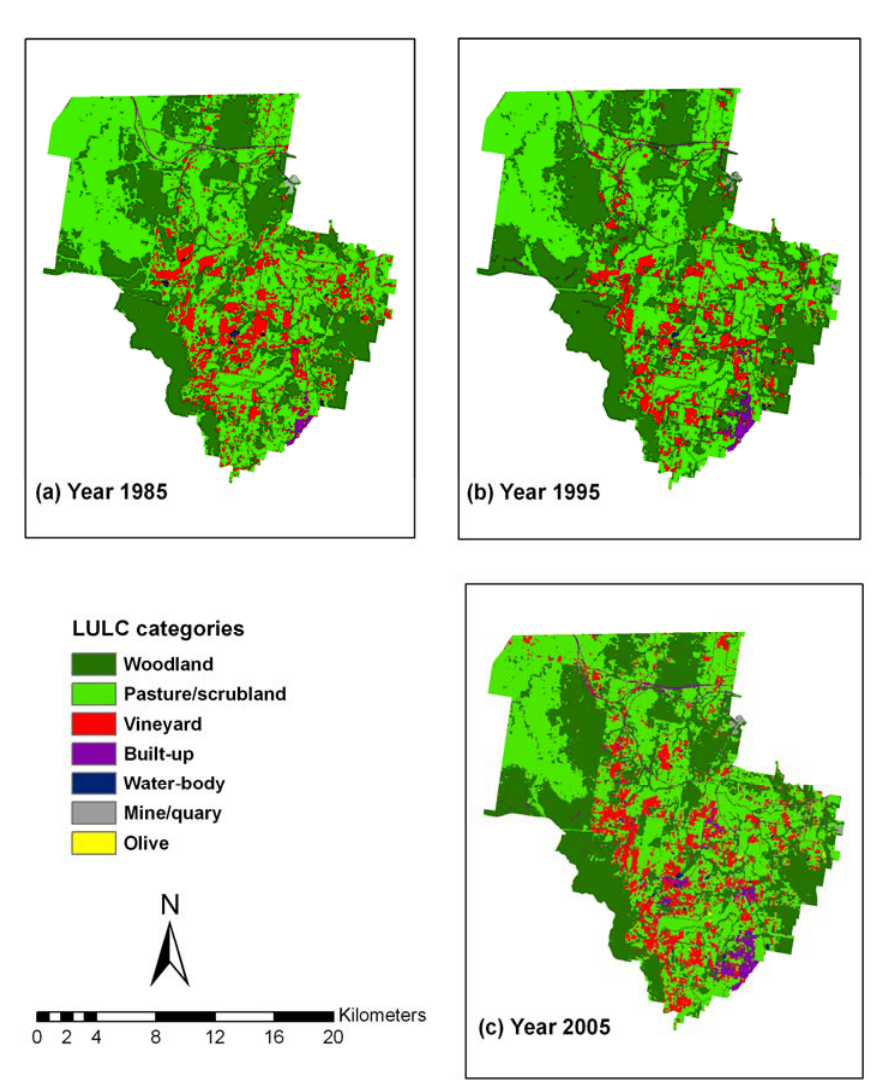
Figure 4. Post classification corrected maps for the years: (a) 1985, (b) 1995 and (c)